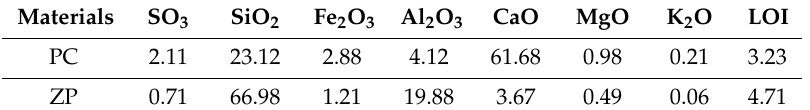
Table 1. Chemical compositions of PC and ZP (wt.%).